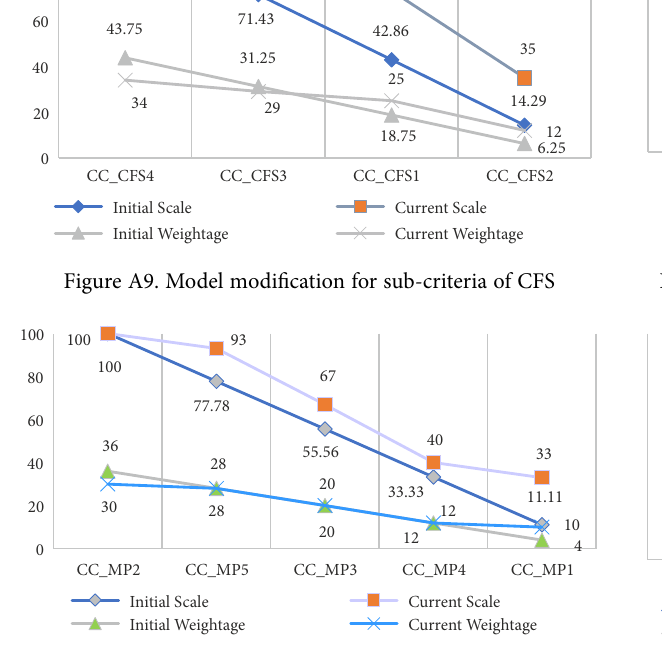
Figure A11. Model modification for sub-criteria of MP Figure A12. Model modification for sub-criteria of RM